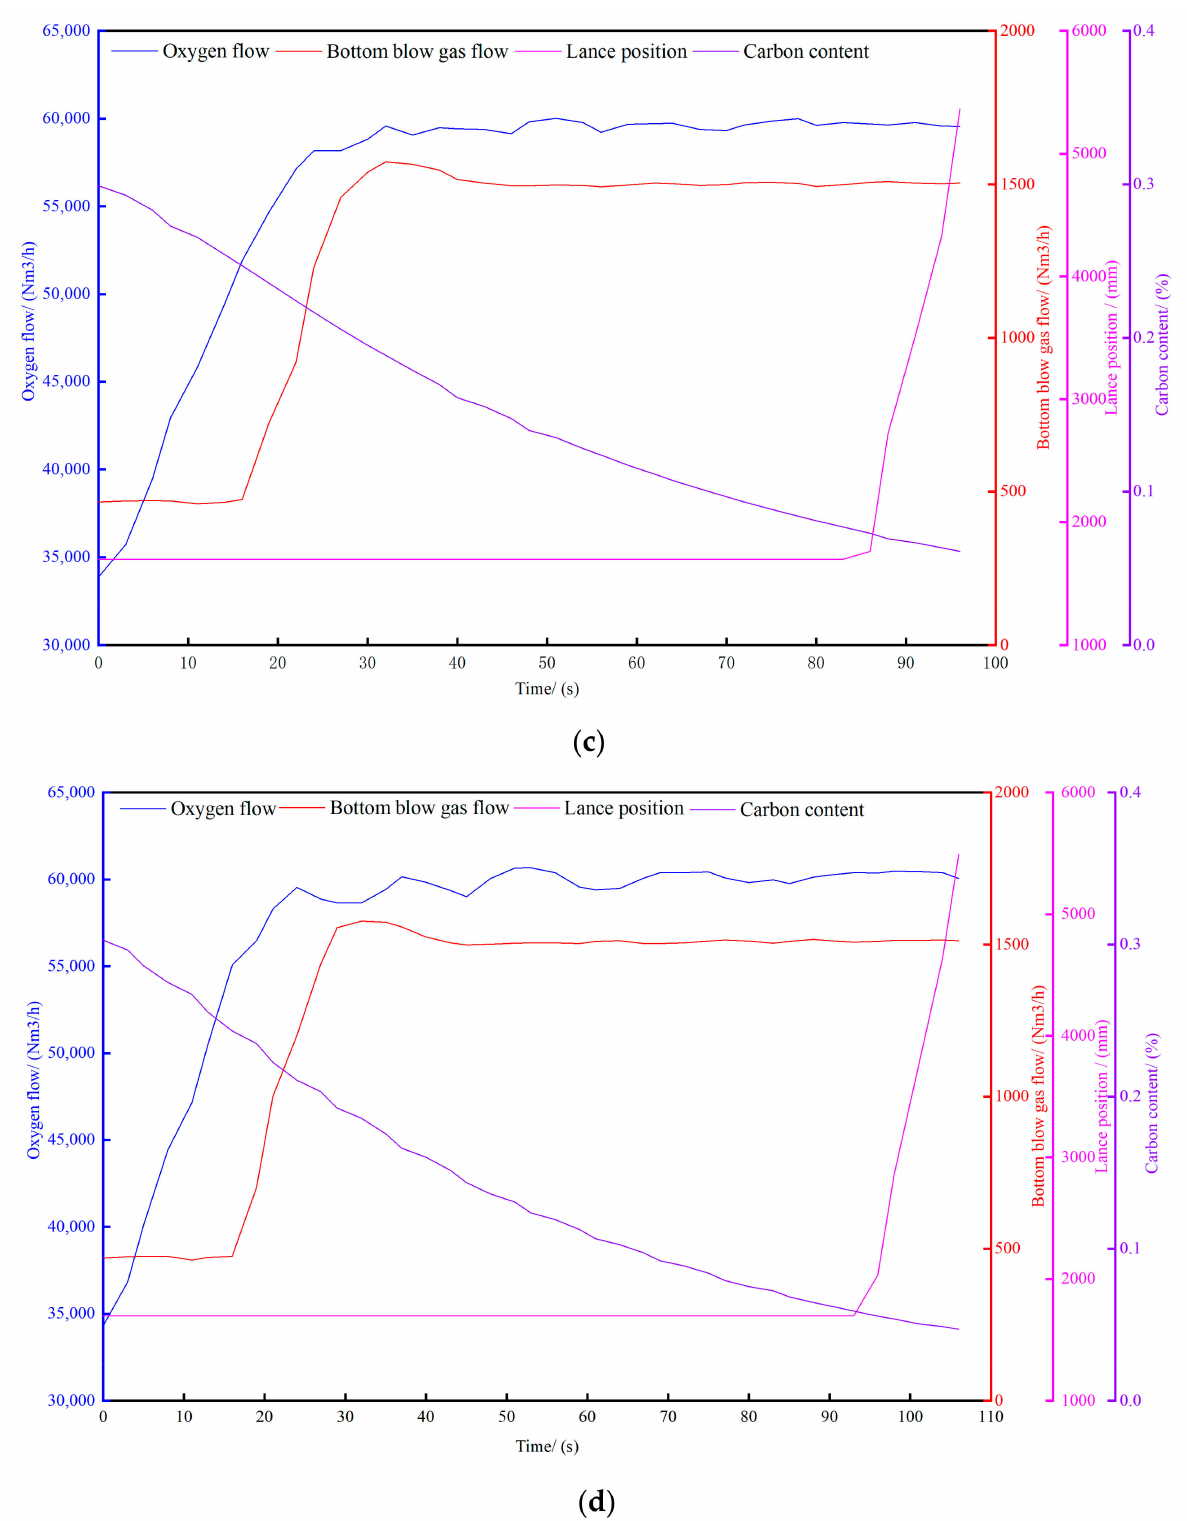
Figure 10. Process parameters for the late blowing stage of similar cases. ( a ) Heat 2; ( b ) Heat 3; ( c ) Heat 4; ( d ) Heat